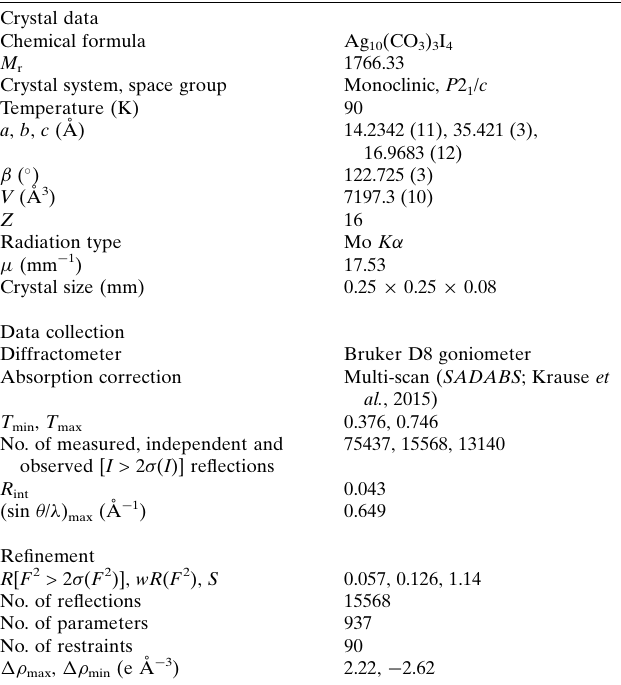
Table 2 Experimental details. Crystal data Chemical